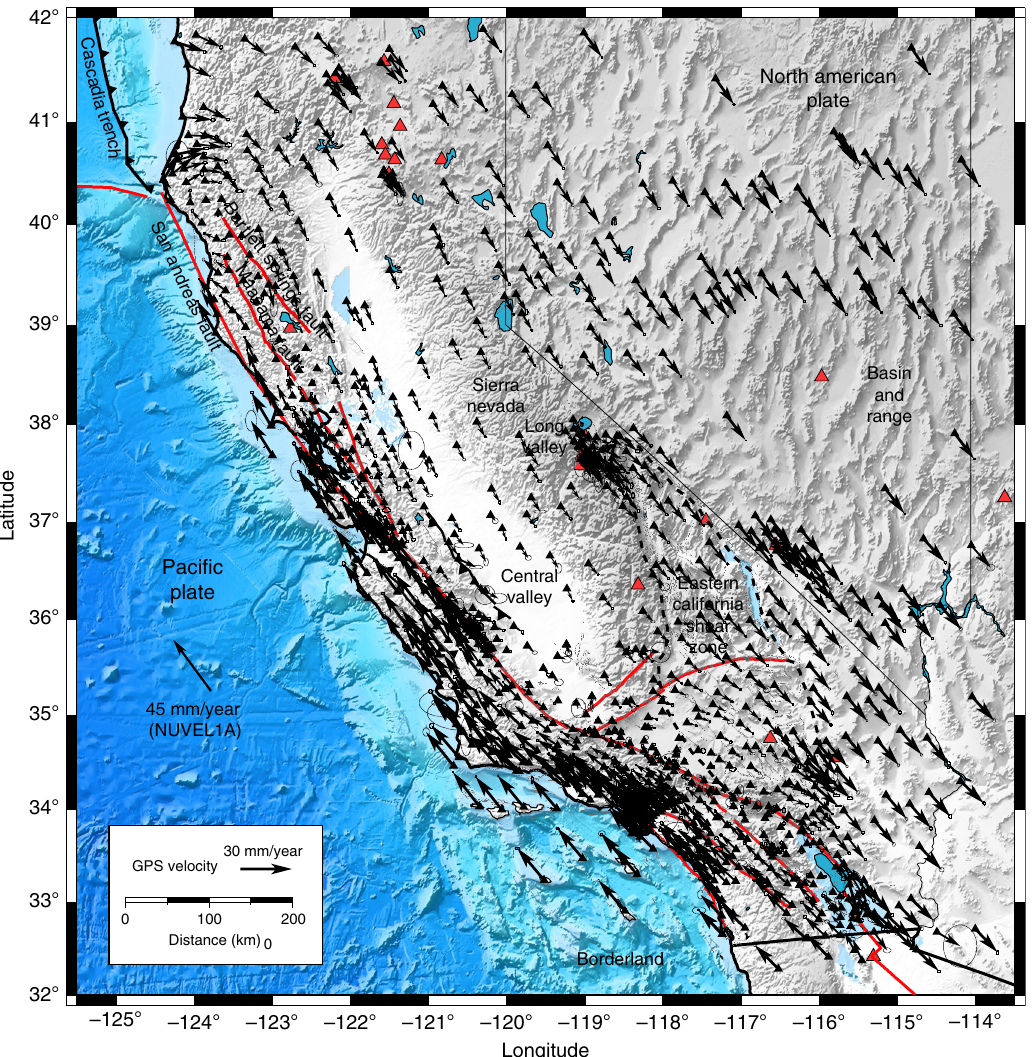
Fig. 1 Distribution of the GPS velocity around the San Andreas fault. The GPS velocity fi eld is available at ftp://data-out.unavco.org/pub/products/ velocity/. The red triangles correspond to quaternary volcanos. The trace of major faults is from the USGS catalog of quaternary faults https://www.usgs. gov/natural-hazards/earthquake-hazards/faults. The NUVEL1A velocity is for the Paci fi c plate relative to the North American plate 76 . The dashed contour indicates the approximate extent of the Eastern California Shear